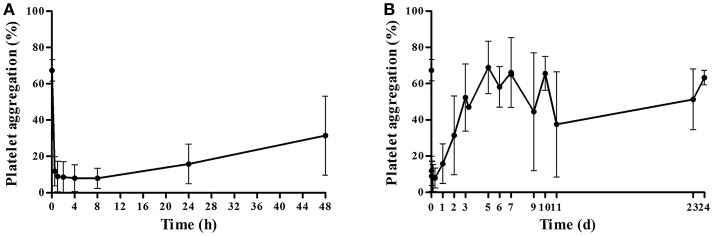
Average platelet aggregation after a single dose of ticagrelor in healthy subjects. (A) Average platelet aggregation during 0–48 h after a single 180 mg oral dose of ticagrelor (mean ± SD); (B) average platelet aggregation within all points of time after a single 180 mg oral dose of ticagrelor (mean ± SD).